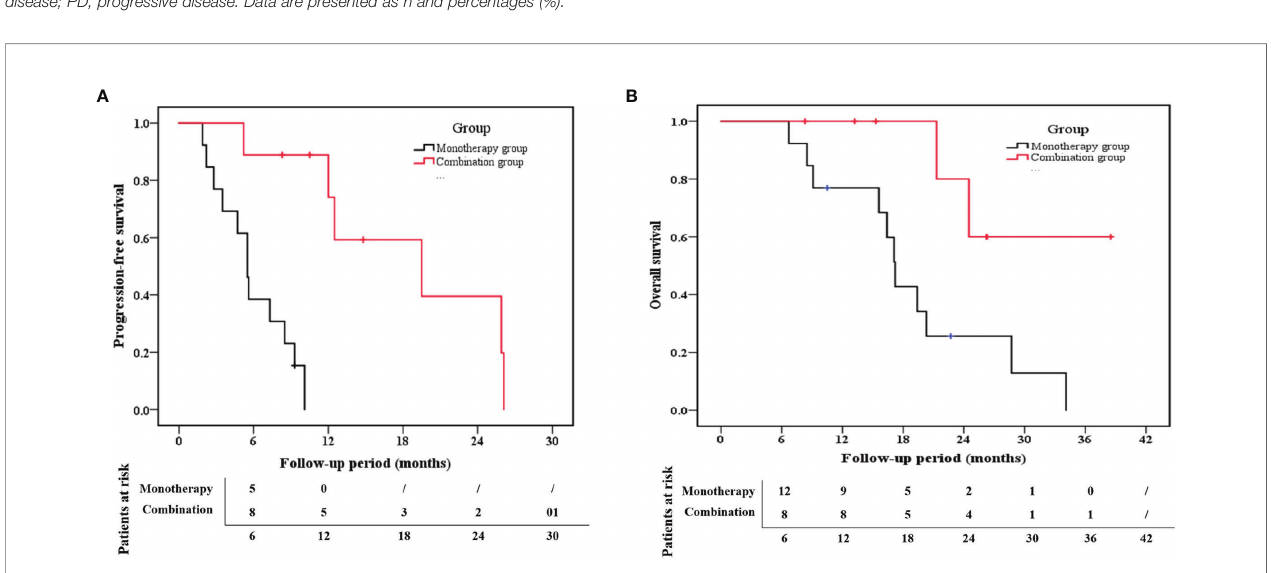
FIGURE 4 | Kaplan – Meier estimates of (A) progression-free survival (PFS) and (B) overall survival (OS) for the combination group and the monotherapy group.